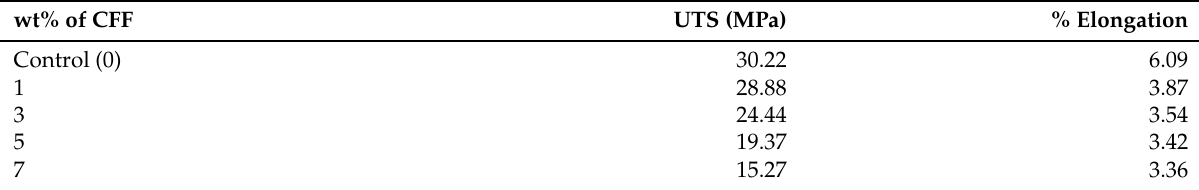
Table 5: Tensile properties for various composition of CFF